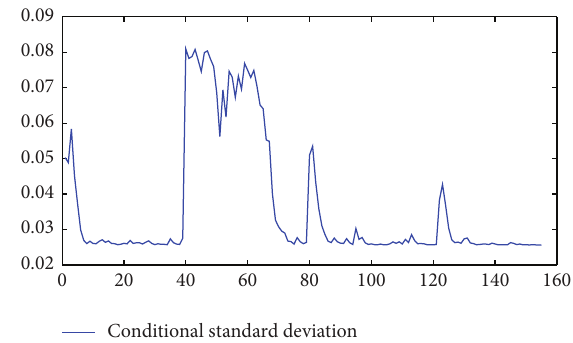
Figure 13: Estimated conditional standard deviation for DAX index.